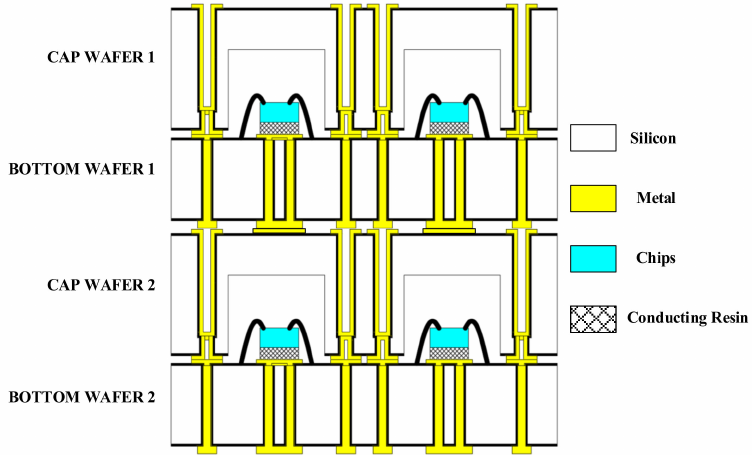
Figure 1. Structural diagram of the 3DHI WLP process with up to 4 stacked HR-Si